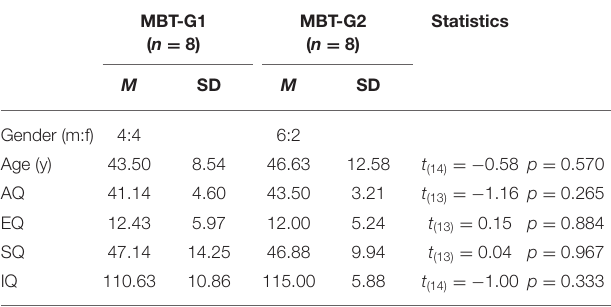
TABLE 1 | Demographic and clinical